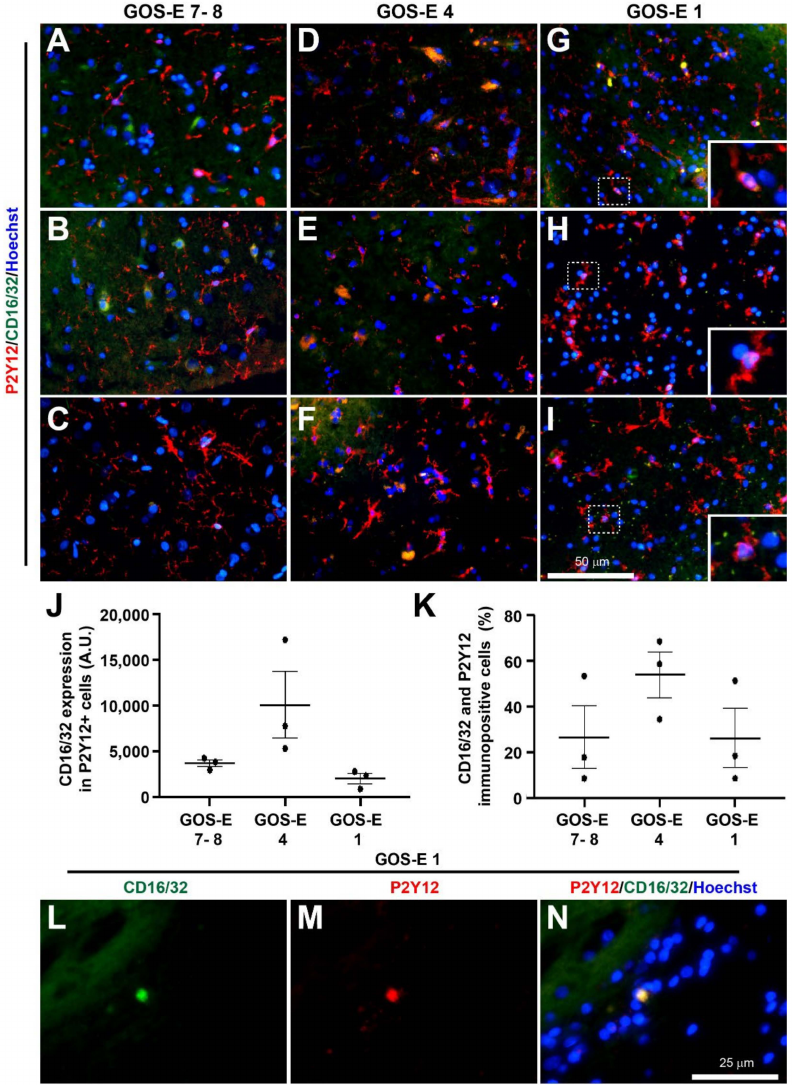
Figure 11. Classical pro-inflammatory CD16/32 marker and P2Y12-immunoreactivity in brain biop- sies after severe TBI. Microglia are stained using P2Y12 (red) and the classical pro-inflammatory marker are stained with CD16/32 (green). Photomicrographs of P2Y12 and CD16/32 immunostaining in 3 individual biopsies from patients with a GOS-E 7–8 ( A – C ). Photomicrographs of P2Y12 and CD16/32 immunostaining in 3 individual biopsies from patients with a GOS-E 4 ( D – F ). Photomi- crographs of P2Y12 and CD16/32 immunostaining in 3 individual biopsies from patients with a GOS-E 1 ( G – I ). Inserts are enlarged dashed boxes showing cells with P2Y12 and CD16/32 coexpres- sion ( G – I ). No significance between immunoexpression in the GOS-E groups detected for overall CD16/32 expression ( J ) and the number of CD16/32 and P2Y12 positive cells ( K ). A limited number of circular cells with both strong CD16/32 and P2Y12 can be detected, but are only present in the GOS-E 1 group ( L – N ). Results represent mean ± SEM. N = 3 per group. Scale bars 50 µ m ( A – I ) and 25 µ m ( L – N ). Cellular nuclei stained with Hoechst